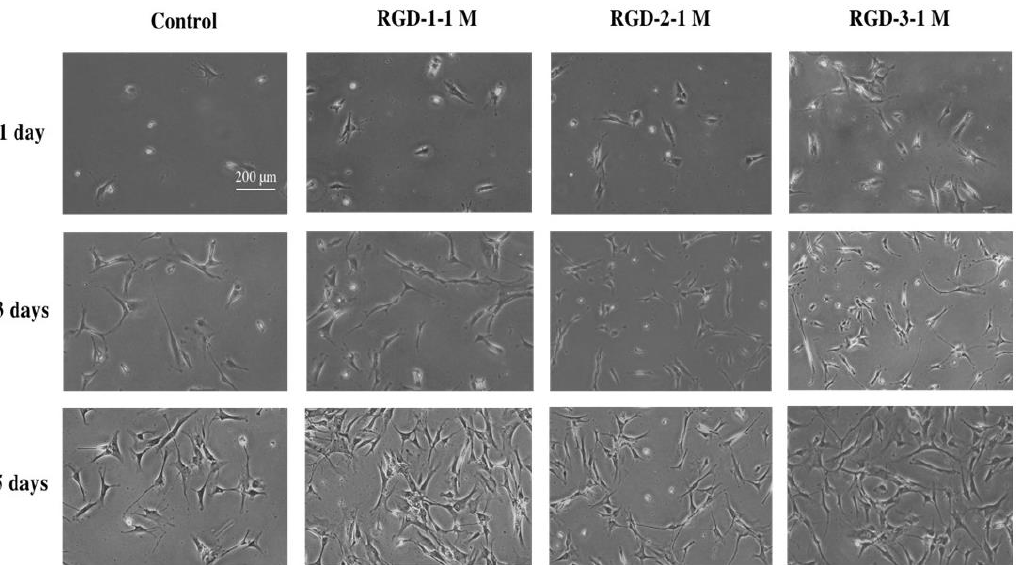
Figure 1. Cell morphology observation. hDPSCs were spread on non-TCPP plates. Plates were coated with 1 M soluble RGD-1, RGD-2, or RGD-3 in the experiment group, dH 2 O was used as a control. Cell morphology was observed on days one, three, and five. The scale bar in the control group image on day one applies to all panels (bar = 200 µM).